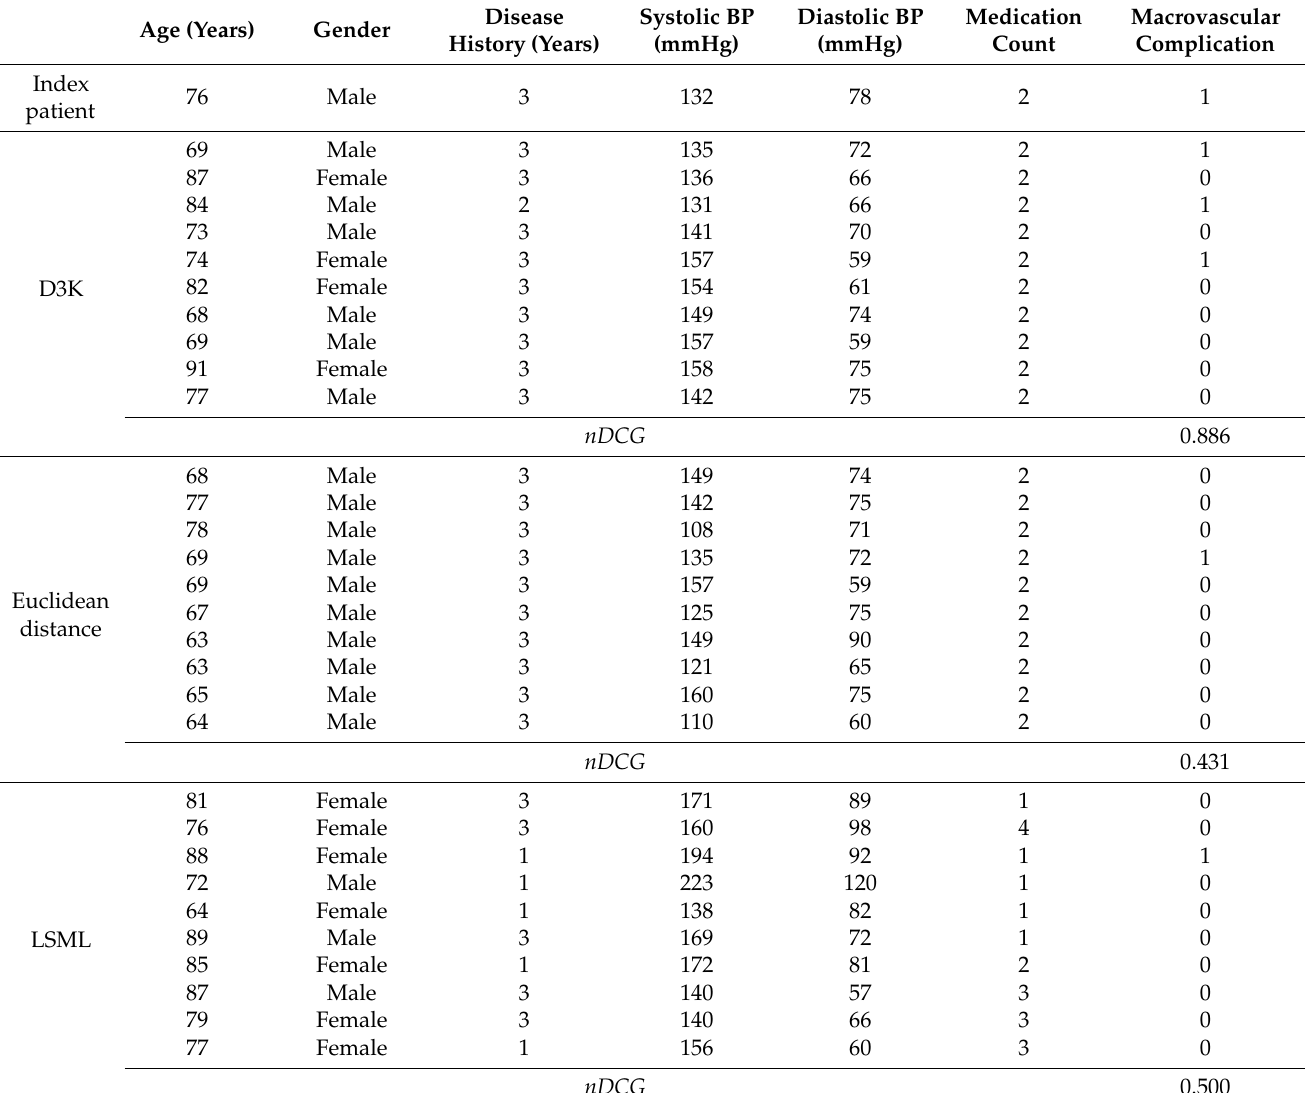
Table 9. A patient example and the retrieved 10 most similar